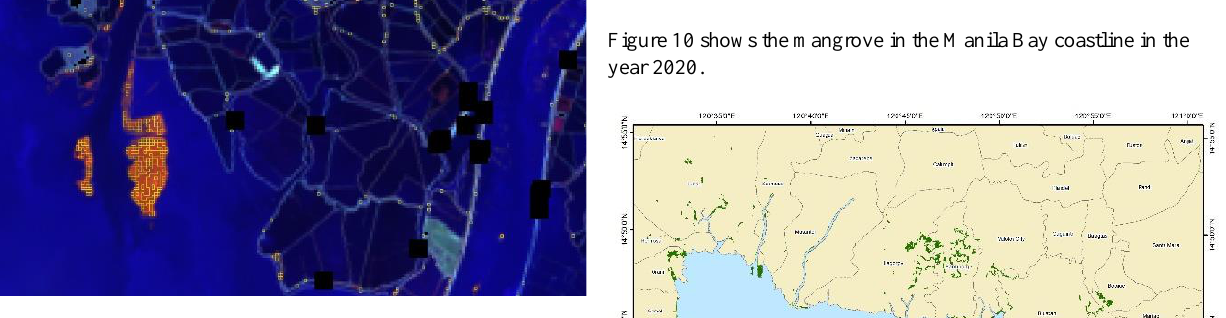
Figure 7. False color composite showing mangroves 3.3